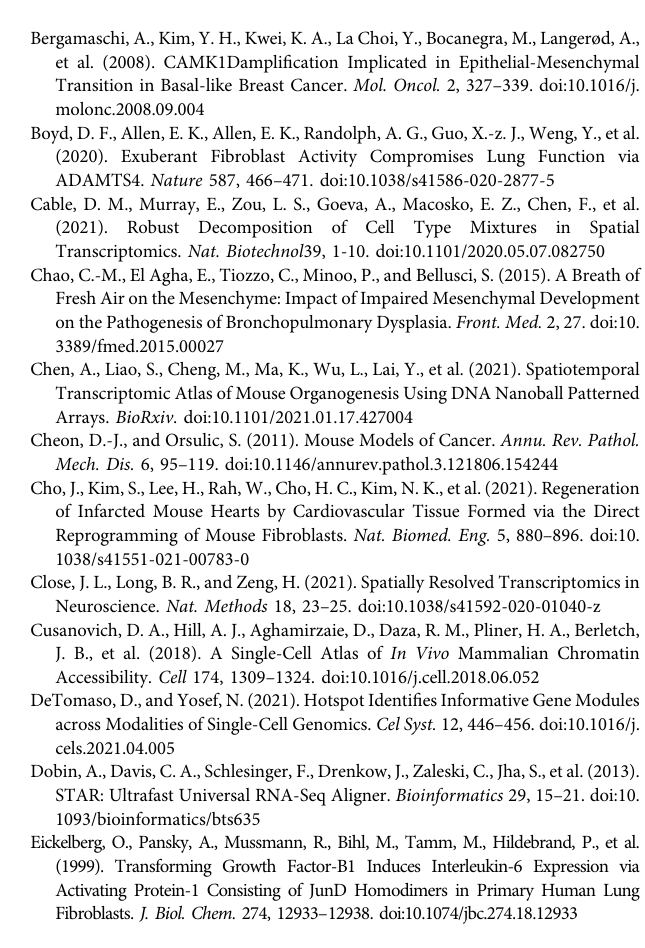
determination (R 2 ) of Section 2 and Section 1. (B) The UMI (left) and the percent of mitochondrial genes (middle) spatial distribution patterns of the Stereo-seq Section 3, and the Coef fi cient of determination (R 2 ) of Section 3 and Section 1. Supplementary Figure 2 | Spatial distribution of the 17 hotspot gene groups. Supplementary Figure 3 | Identi fi cation of the pattern of genes and structures in thelung. (A) Spatialdistributionofgenes: Ager , Dcn , Cdk8 ,and Foxj1 . (B) Allgroups to tissue section by clustering, to gain the spatial clustering. (C) Percentage of the content of each cluster in section. (D) Correlation of each cluster in the lung section. (E) Percentageexpressionandaverageexpressionofeachclustercontaininggenes in the lung section. Supplementary Figure 4 | Identi fi cation of the differential express genes and functions in the proximal and distal lung. (A) The differential express genes in the proximal and distal lung. (B) The gene pathway enrichment analyses of the genes in the proximal and distal lung. Supplementary Figure 5 | The distribution of genes and cells in Stereo-seq and Visium. (A) The distribution of Acta2 , Tmem100 , Myh6, and Jarid2 in bin1, bin5, and bin10 of Stereo-seq. (B) The distribution of Ciliated, Adventitial Fibroblast, and AT2 of Visum. Supplementary Table 1 | Sequencing dataset quality control of three Stereo-seq sections. Supplementary Table 2 | List of genes in groups formed by identical expression patterns. Supplementary Table 3 | Markers and annotation for each cluster in the mouse lung